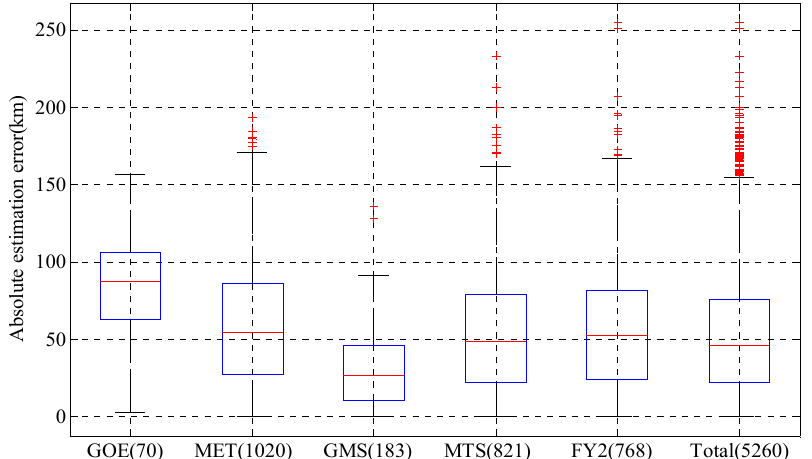
Figure 3. Results of the tests for the estimation of the size of TCs. The red line represents the median, the upper limit of the blue box represents the 75th percentile, and the lower limit of the blue box represents the 25th percentile. The small red lines above or under the black top or bottom lines are outliers.